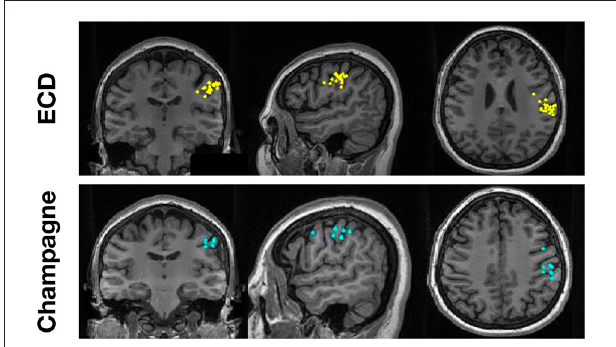
FIGURE 1 | A representative “straightforward” case comparing ECDss and Champagne algorithms for spike localization (Subject 13). The top row shows ECDss fits with errors < 10% (yellow dots); the bottom row shows Champagne localization for the same spikes (blue dots).